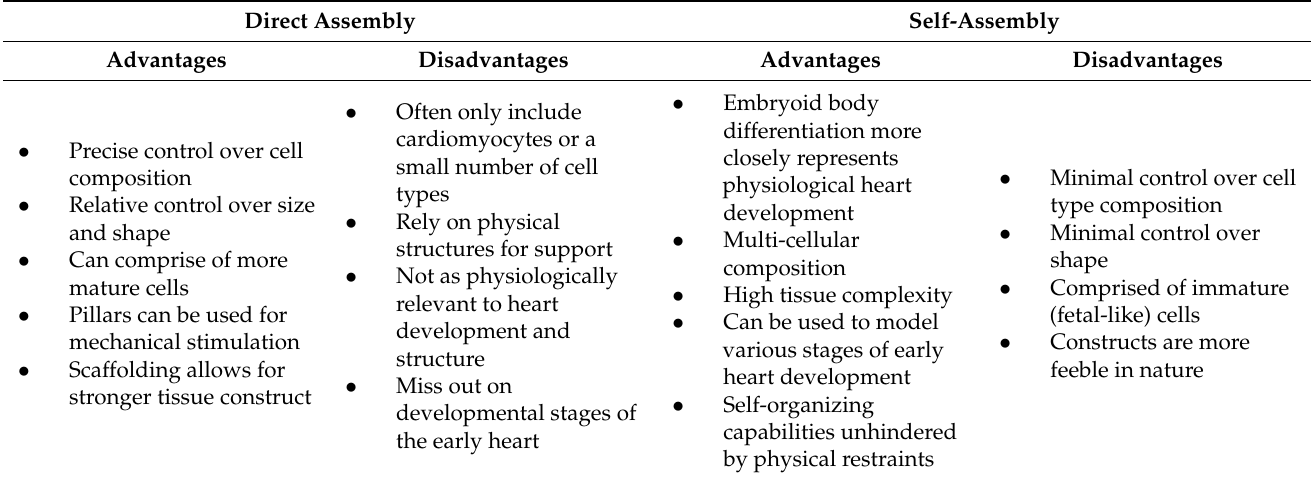
Table 3. Direct Assembly vs. Self-Assembly: advantages and